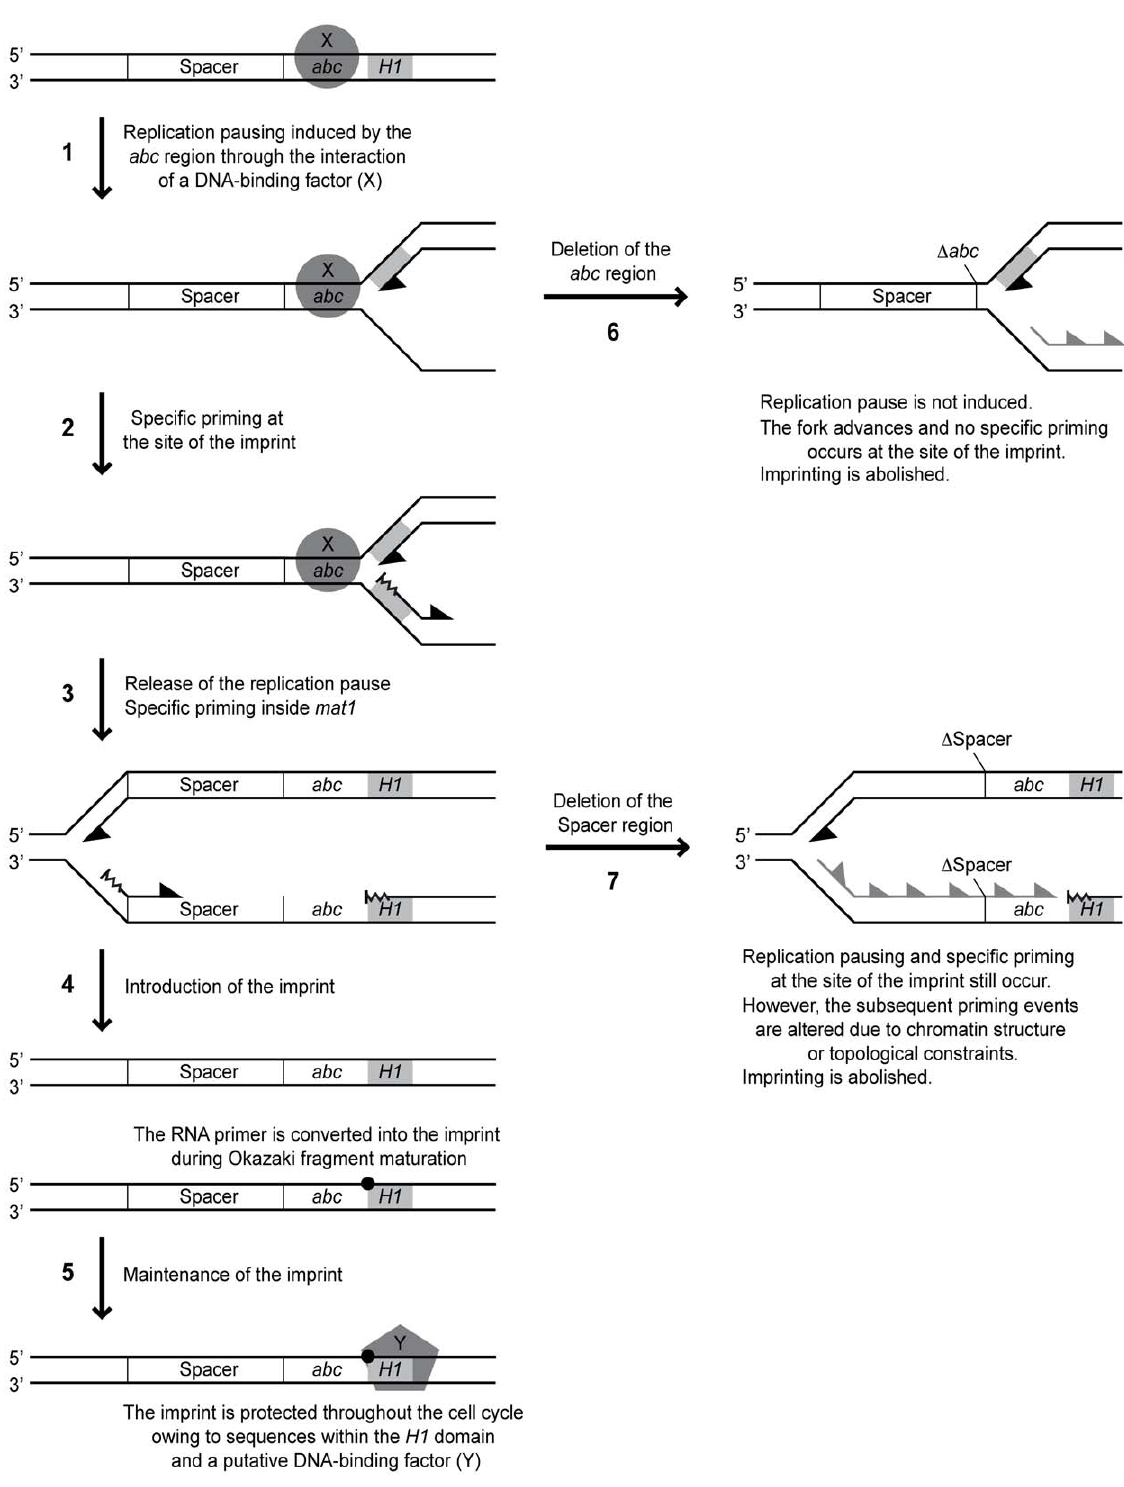
Figure 10. Working model for MPS1 replication pausing and mat1 imprinting. The mat1 locus and the events that occur during replication of it are depicted with line drawings. Left, molecular events that take place in the wild-type strain. Right, events occurring when cis-acting mutations are introduced. Positions of the spacer and abc regions and the H1 domain (grey boxes) are shown. The orientations of the DNA strands are indicated. The putative proteins mediating MPS1 activity and maintenance of the imprint are displayed as a circle and a pentagon, respectively. The imprint is marked with a black spot. Leading- and lagging-strand replication is represented with black half arrowheads. Specific priming is depicted as wavy lines, while loss of it is indicated with grey half arrowheads. Left, positions of the cis-acting deletions are given. See main text for description of each step.